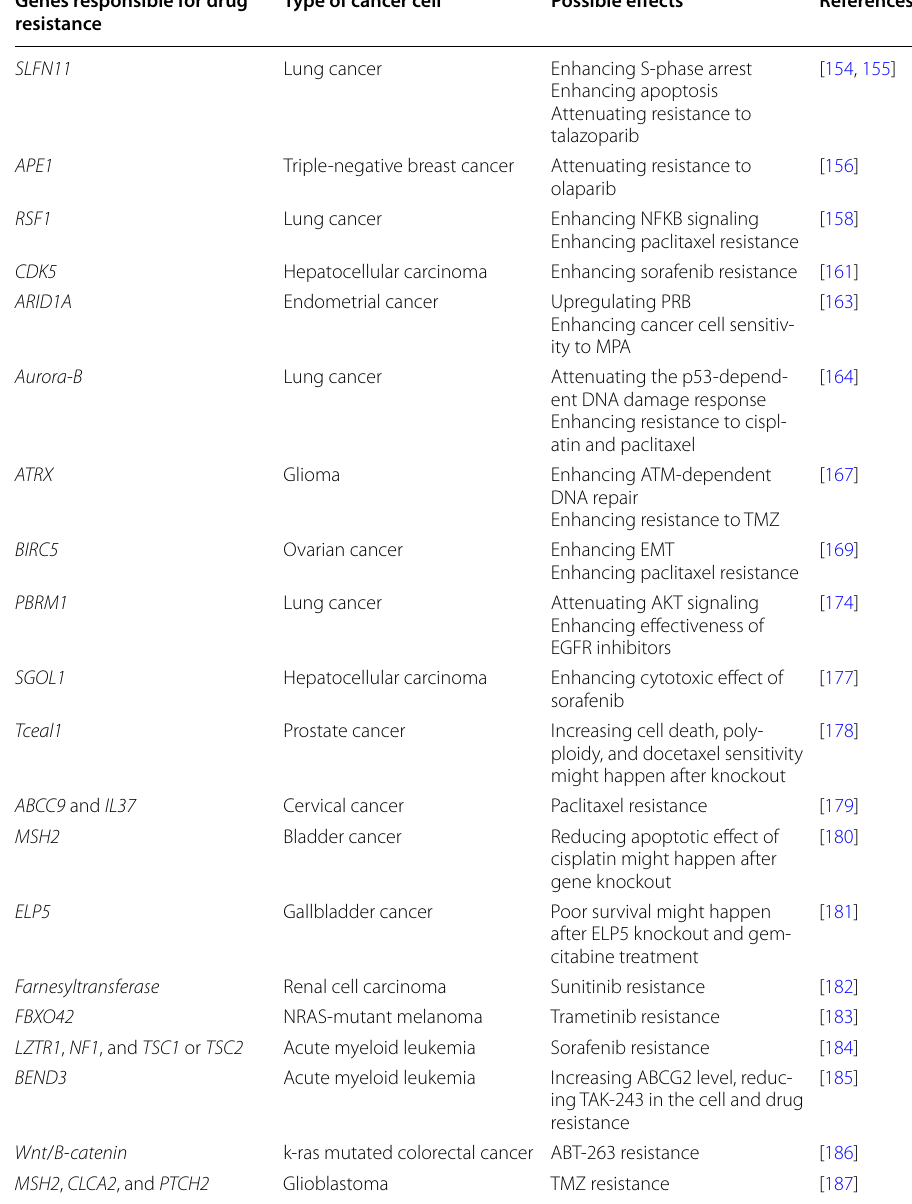
Table 2 Identified genes involved in drug resistance using CRISPR/Cas9 technology Genes responsible for drug